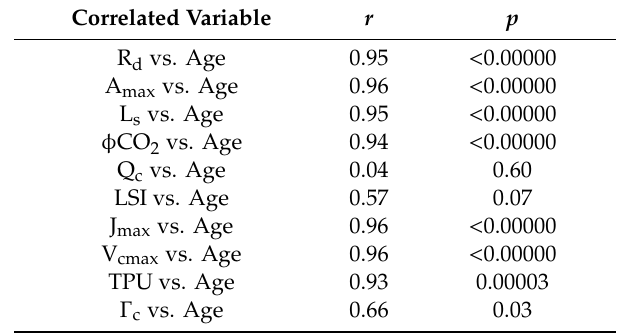
Table 1. Pearson’s correlation coe ffi cients ( r ) and significance levels ( p ) for correlated variables. Samples were pooled for treatments and crown position. Leaf respiration rate (R d ), quantum yield ( φ CO 2 ), maximum photosynthesis (A max ), leaf light saturation (L s ), light compensation point (Q c ),